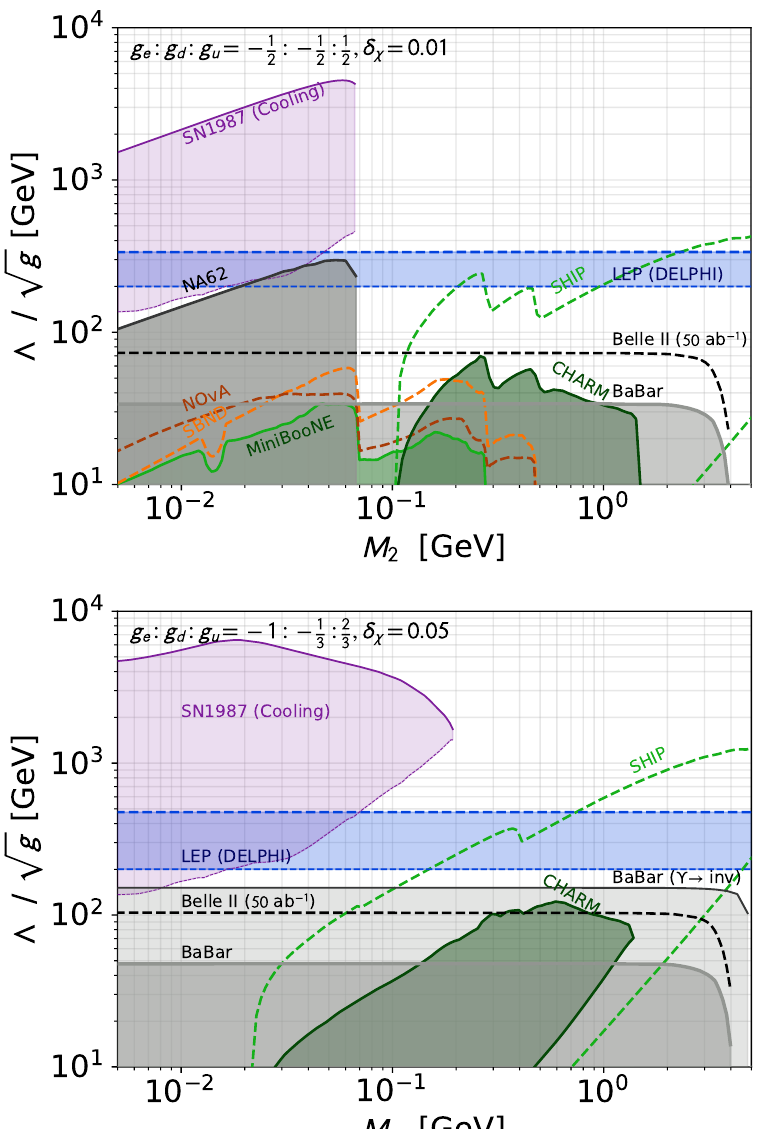
Figure 14 . Limits and projected experimental sensitivity for small dark sector mass splitting for (a) an axial-vector current operator with Z-aligned coupling, with (cid:14) (cid:31) = 0 : 01, and (b) a vector current operator with electromagnetically-aligned coupling for (cid:14) (cid:31) = 0 : 05. Grey (cid:13)at regions indicates coverage from mono-photon at BaBar [68], dashed grey line Belle-II projections [68]. The light grey regions at low M 2 indicate the exclusion from NA62 (cid:25) 0 ! inv limits [76]. The shaded blue region is the mono- (cid:13) limit from LEP [72]. Limits from (cid:31) 2 ! (cid:31) 1 e + e (cid:0) : the dark green region is the exclusion from CHARM [46]. The 10 events reach by SHiP is shown in dashed orange. Scattering limits at MiniBooNE [28] are shown in light green, and SBND [61] and NO (cid:23) A [46] in orange and red. The normalised splitting (cid:14) (cid:31) is de(cid:12)ned in eq. (2.4).